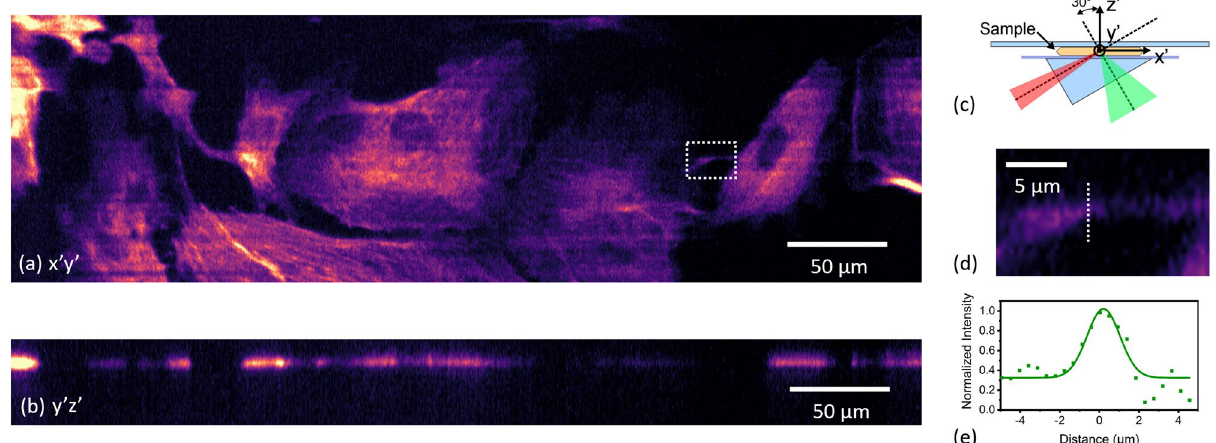
Figure 7. Volume slices of the coordinate transformed image data of a 10 µm thick fixed BPAE slide with F-actin labelled with Alexa Fluor 488; ( a ) x ′ y ′ slice, ( b ) y ′ z ′ slice, ( c ) schematic of the imaging coordinate system relative to the sample and illumination, ( d ) zoom on smaller strand of F-actin highlighted within the intensity profiles in ( a ), ( e ) fit to the cross-section data of the actin strand in ( c